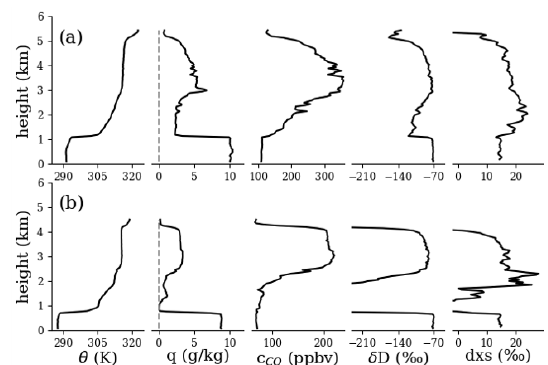
Figure 9. Examples of individual vertical profiles for the 2016 sampling period. Potential temperature, humidity, CO concentra- tion, total water δ D, and total water dxs for profiles taken on (a) 31 August (mean latitude 12.75 ◦ S, mean longitude 2.55 ◦ E, mean time 11:42UTC) and on (b) 14 September (19.9 ◦ S, 10.2 ◦ E, 09:09UTC). Data were averaged into 50m vertical bins. The dxs has an additional three-bin running mean applied. The δ D and dxs in (b) become very low where q approaches 0 and are not